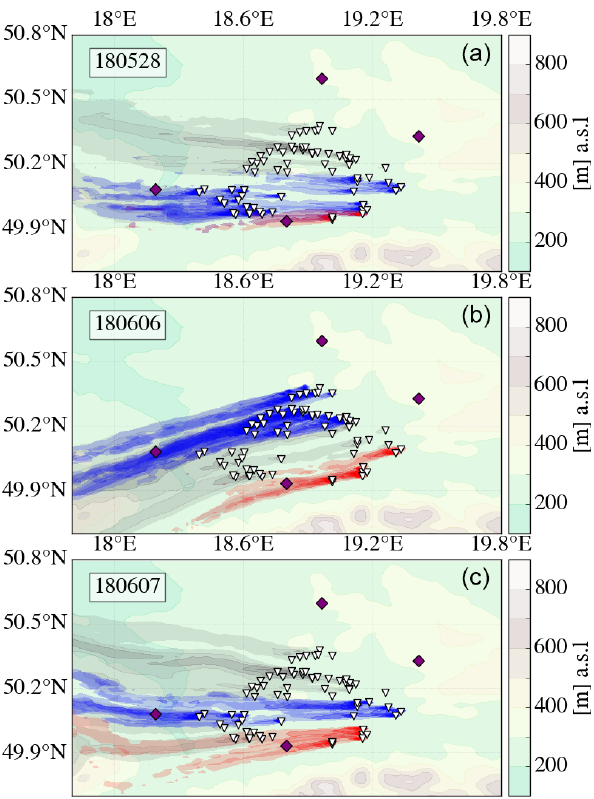
Figure 6. FLEXPART simulations of CH 4 trajectories released from the USCB ventilation shafts for 28 May (a) , 6 June (b) , and 7 June 2018 (c) (simulation at 12:04UT). Red, blue, and grey shad- ings indicate trajectories that went over Pustelnik (S), Raciborz (W), or none of the observation sites, respectively. Background shading indicates topography.